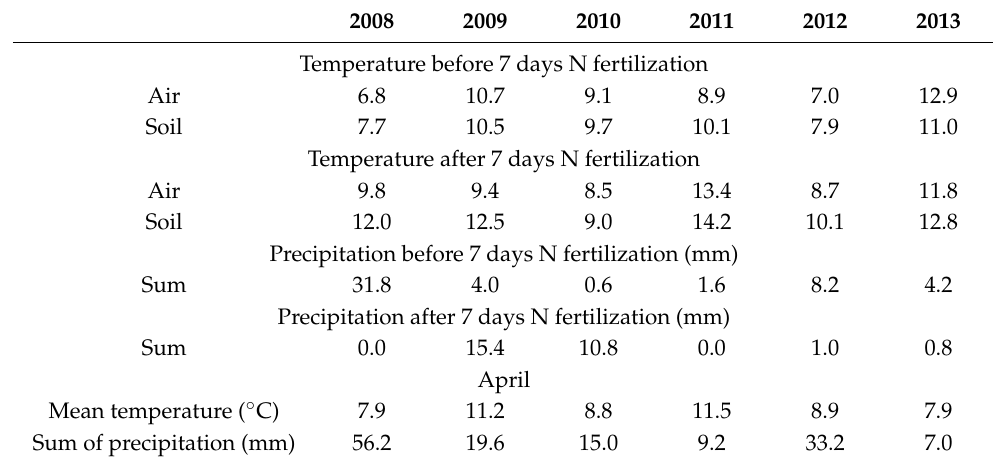
Table 1. Precipitation and air temperature before and after nitrogen fertilization in